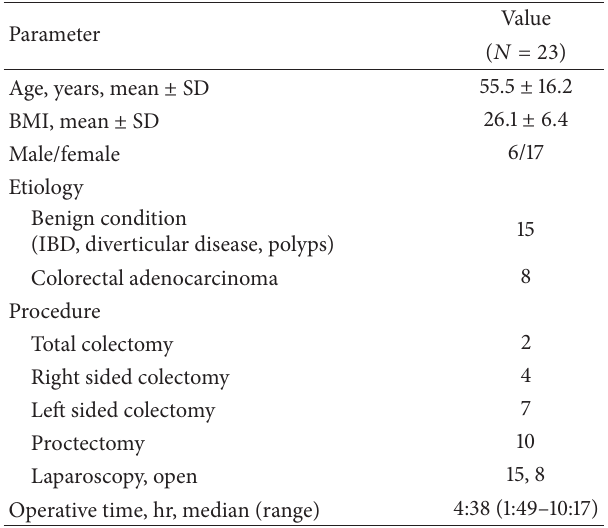
Table 1: Patients’ clinical characteristics and operative